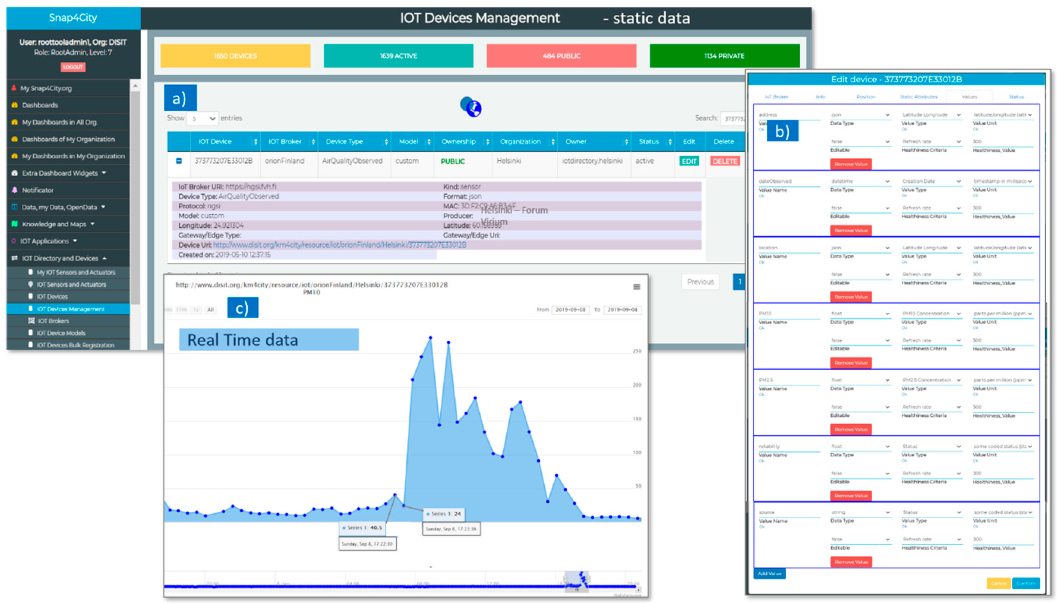
Figure 7. Data gathering on Snap4City Broker: ( a , b ) Static data related to each air quality sensor, called IoT Device in the Snap4City Platform; ( c ) History view related to the Real Time data: PM10 (and PM2.5), with frequency of 1 min.